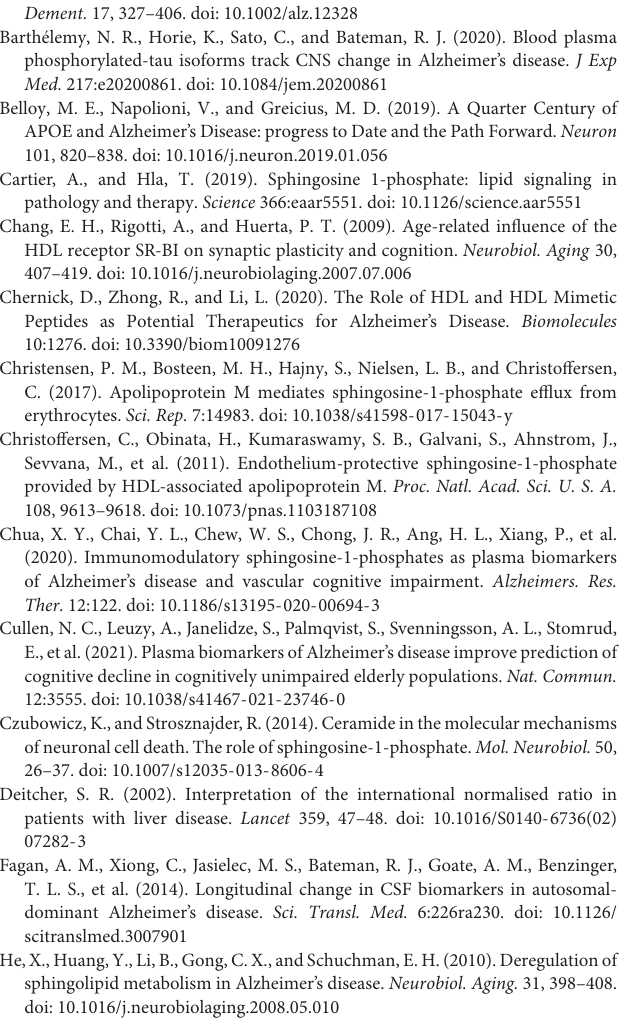
Supplementary Figure 1 | The flow diagram for the enrollment of the two groups. MMSE, mini-mental state examination; MoCA, Montreal cognitive assessment; ADL, activities of daily living; CDR-SB, Clinical Dementia Rating; CT, Computed tomography; MRI, Magnetic resonance imaging; AD, Alzheimer’s disease; CN, cognitively normal.